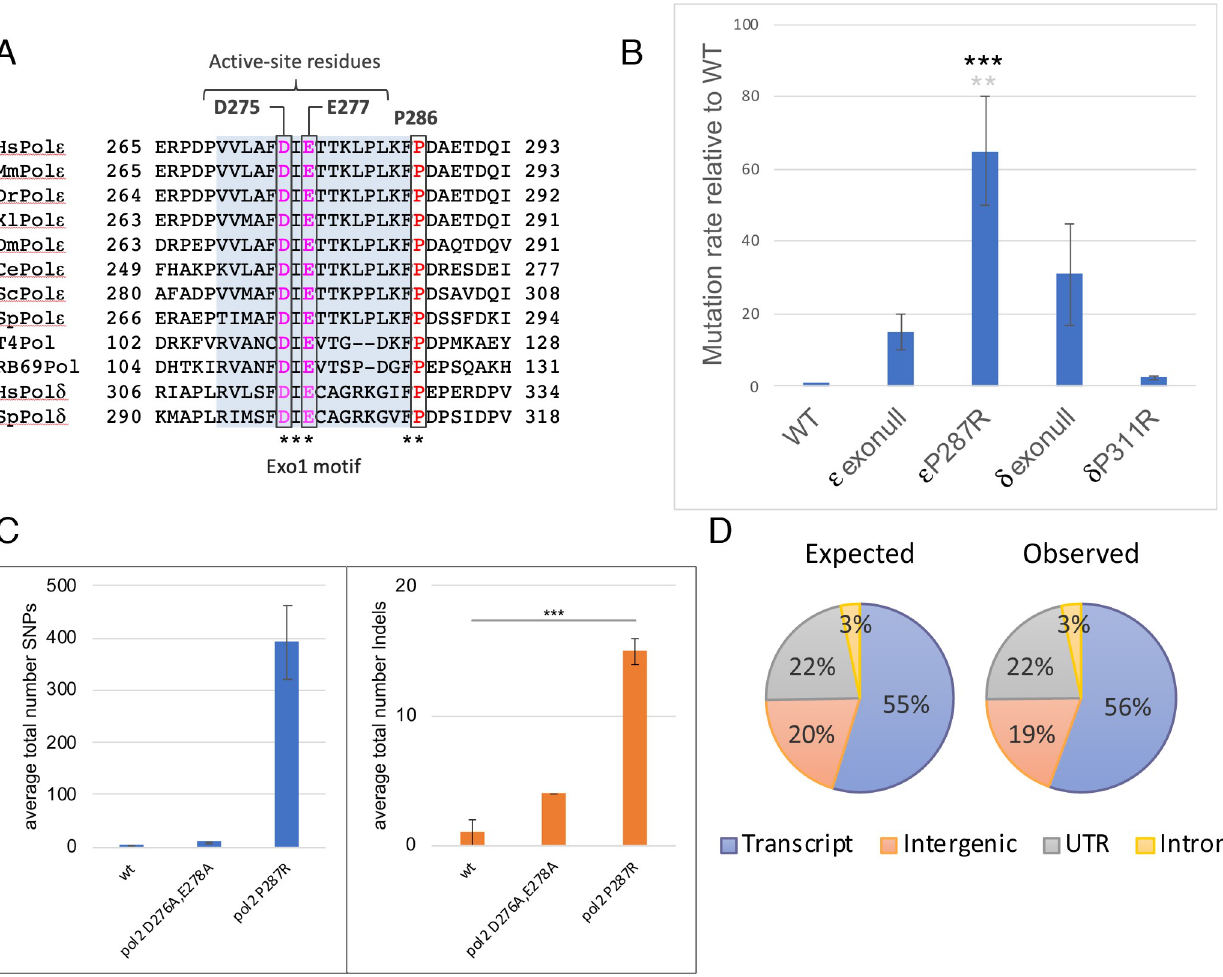
Fig 1. The POLE-P286R hypermutagenic phenotype is conserved in S . pombe . (A) Multiple sequence alignment showing that the Pro286 residue (red) adjacent to the Exo I domain (blue shadow) is absolutely conserved in Pol ε and Pol δ orthologues as well as in T4 and RB69 phage polymerases. Catalytic residues of the 3’- > 5’ exonuclease domain are highlighted in magenta. (B) CanR mutation rates of pol2-P287R , pol3-P311R (equivalent proline to Pol2-P287), and exonull Pol2 and Pol3 relative to wild type. A multiple comparison using the ordinary one-way ANOVA revealed that the pol2-P287R strain has a significantly greater mutation rate compared to wild-type (black asterisks, ��� P < 0.0001) and pol2-D276A/E278A (exonull) (grey asterisks, �� P < 0.01). Numerical data are in S13 Table. (C) Number of base substitutions and indels identified in the 200 generation mutation accumulation (MA) experiment in wild-type, exonull and pol2-P287R cells. The number of lineages set up was: wt 2; pol2-D276 E278A 2; pol2-P287R 3. The average number of mutations is shown and error bars show the range of data. ��� P < 0.001. Numerical data are shown in S10 Table. (D) Expected and observed distribution of mutations obtained in pol2-P287R cells during the MA experiment across different genomic regions.